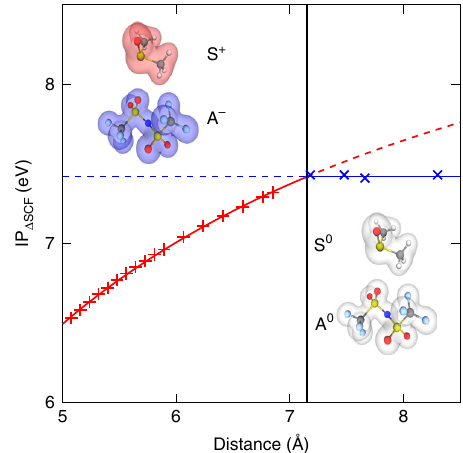
Fig. 3 IP Δ SCF for a (TFSI − , DMSO) con fi guration, with respect to the increasing distance (leftmost point in the plot is the initial con fi guration). The red marks correspond to situations where the solvent is oxidized, the blue marks to situations where the anion is oxidized. The distance plotted here is the distance between the nitrogen atom of the TFSI − anion and the sulfur atom of the DMSO solvent. The IP for the right part of the plot (where the anion is oxidized) is constant with distance. As shown by the solid red line, the dependence of the left part of the plot is accurately captured by a fi t with the formula IP ¼ constant (cid:1) α